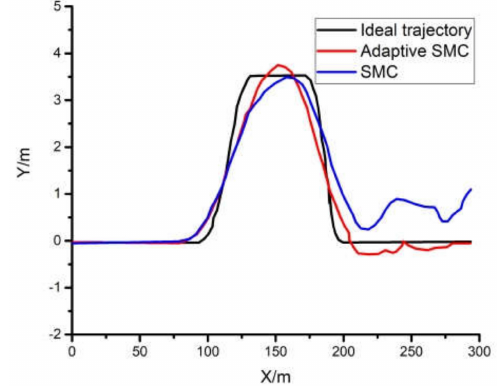
Figure 9. Vehicle centroid trajectory.